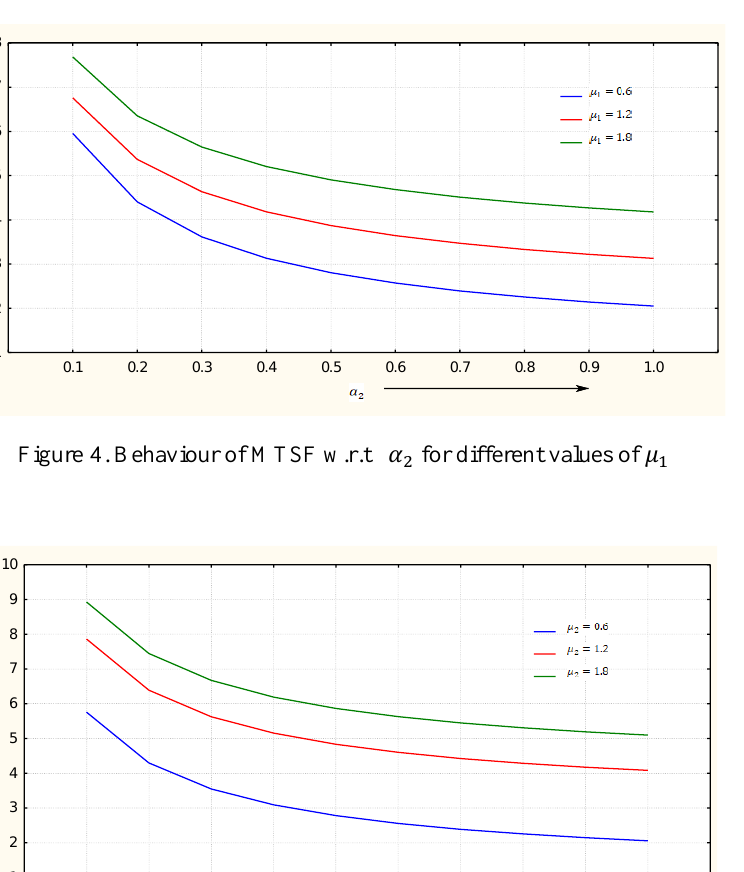
for different values of 𝜇 2